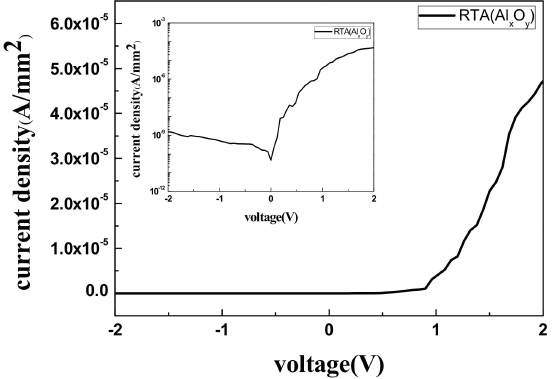
Figure 11. The J–V figure of the SBDs with Al x O x guard ring showed a 4.62 × 10 − 11 A/mm 2 saturation current density ( Js